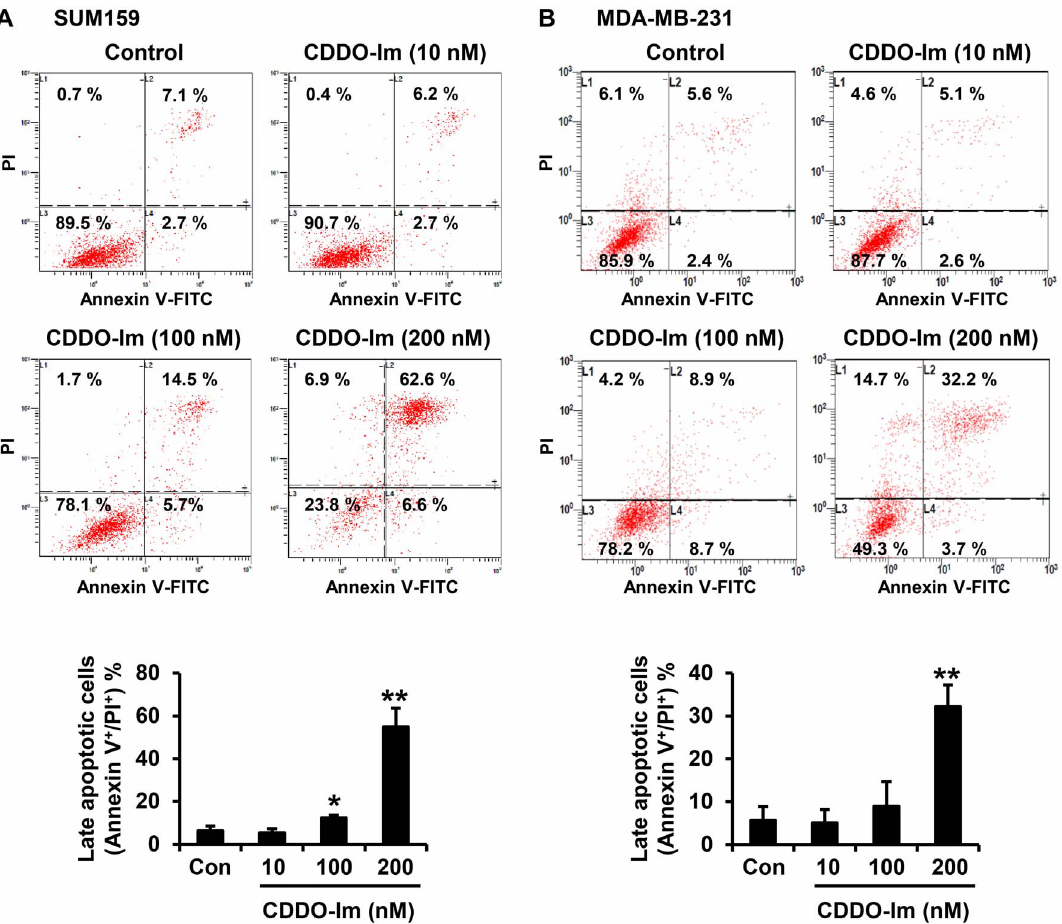
Figure 2. Induction of apoptosis by CDDO-Im in triple-negative breast cancer cells. SUM159 cells ( A ) and MDA-MB-231 cells ( B ) were incubated with vehicle control or CDDO-Im (10, 100 or 200 nM) for 24 h. The cells were stained with annexin V and propidium iodide (PI), and apoptotic cell death was determined by flow cytometry. Three separate experiments were conducted for each cell line, and representative results are shown. Averages of the three separate experiments are shown in the graph (*p , 0.05, **p ,